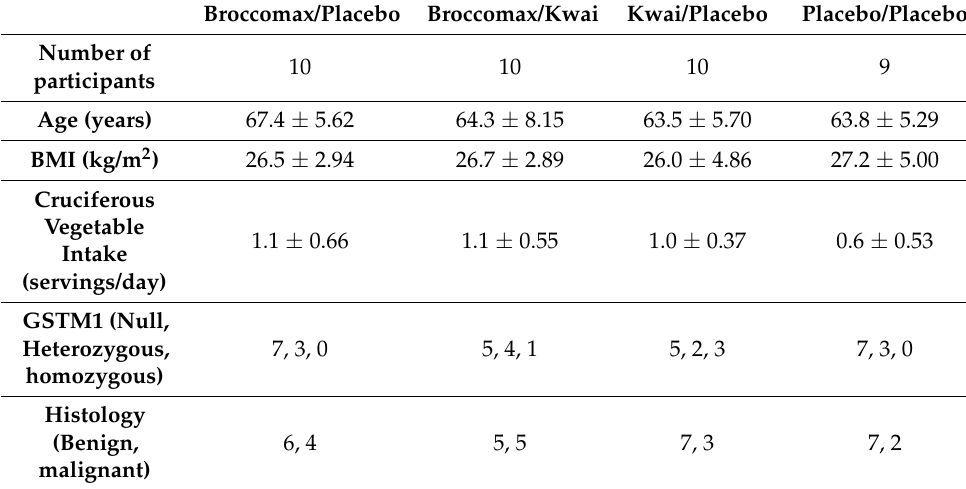
Table 2. Participant demographics, cruciferous vegetable consumption, and histology. The non- validated allium questionnaire did not indicate any outliers in allium consumption amongst the participants.